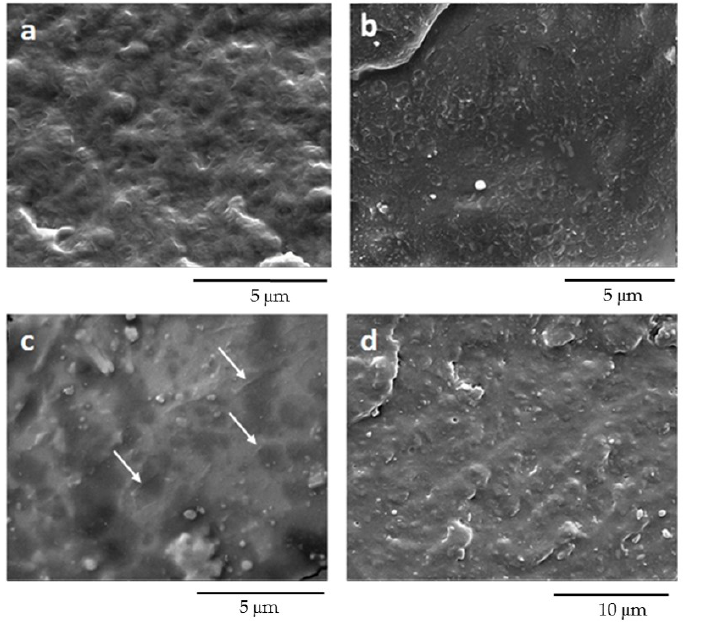
Figure 6. SEM micrographs of ( a ) PBAT, ( b ) PBS, ( c ) PBS25 / PBAT75 and ( d ) PBS75 /